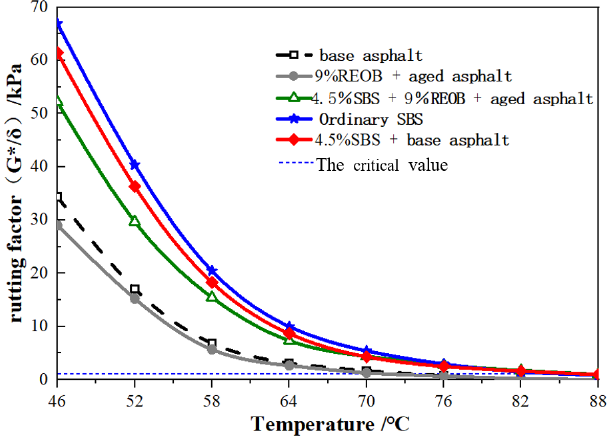
Figure 4. Rutting factor ( G* /sin δ )—temperature curve.